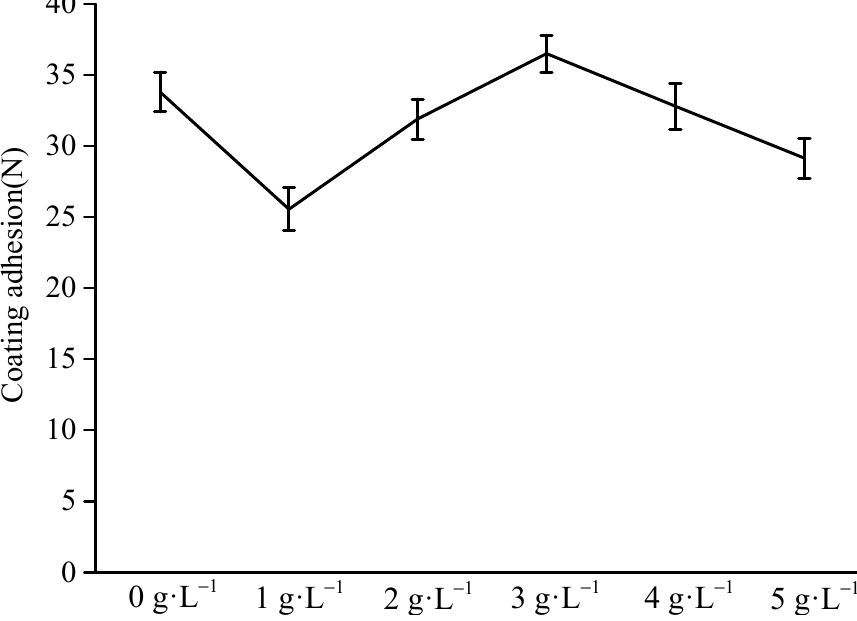
Figure 7. Adhesion of composite coatings with different particle concentrations prepared on 45 steel substrates through scanning electrodeposition.